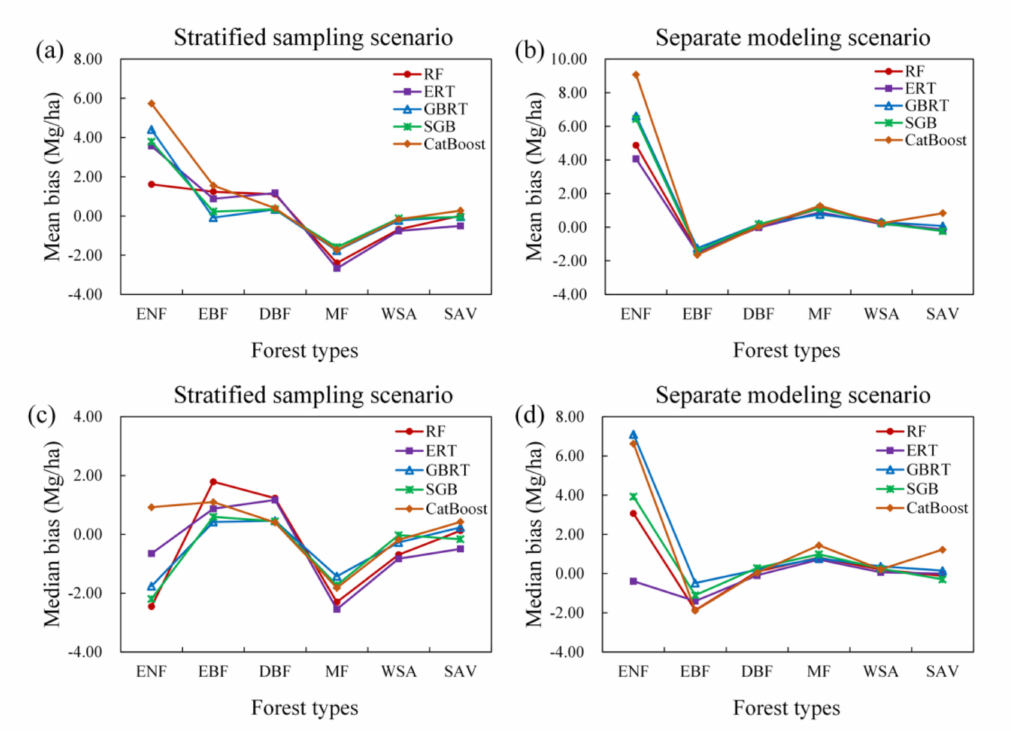
Figure 5. Comparison results of the performances of five tree-based ensemble algorithms (RF, ERT, GBRT, SGB, and CatBoost) for AGB estimates of di ff erent forest types in terms of bias under the stratified sampling scenario ( a , c ) and separate modeling scenario ( b , d